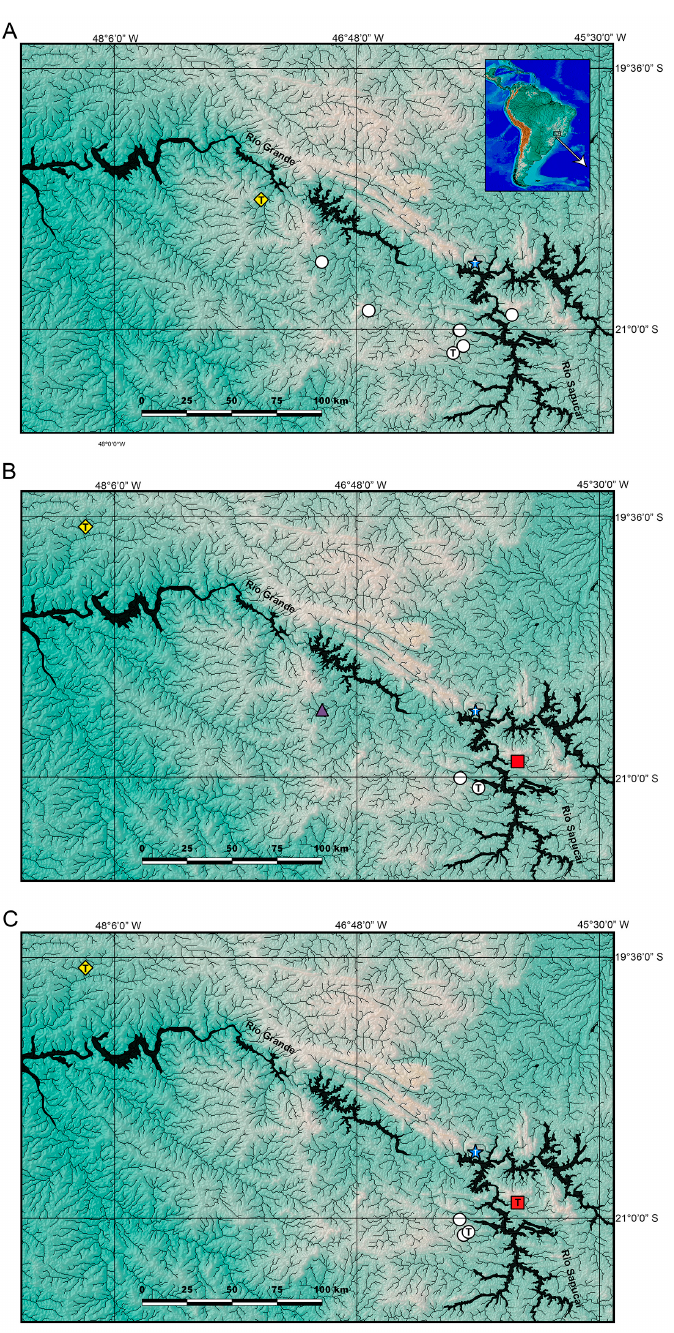
Figure 3. Geographical distribution of Trichomycterus in the Middle Rio Grande drainage. ( A ) T. garbei Costa, Azevedo-Santos & Katz sp. nov. (triangle), T. pirabitira (dots), and T. saturaturatus Costa, Katz & Azevedo-Santos sp. nov. (star); ( B ) T. candidus (dots), T. cf. candidus 1 (triangle), T. cf. candidus 2 (square), T. listruroides Costa, Katz & Azevedo-Santos sp. nov. (star), and T. uberabensis Costa, azevedo-Santos & Katz sp. nov. (lozenge); ( C ) T. adautoleitei Costa, Azevedo-Santos & Katz sp. nov. (square), T. coelhorum Costa, Azevedo-Santos & Katz sp. nov. (lozenge), T. sainthilairei (star), and T. septemradiatus (dots). T indicates type localities.